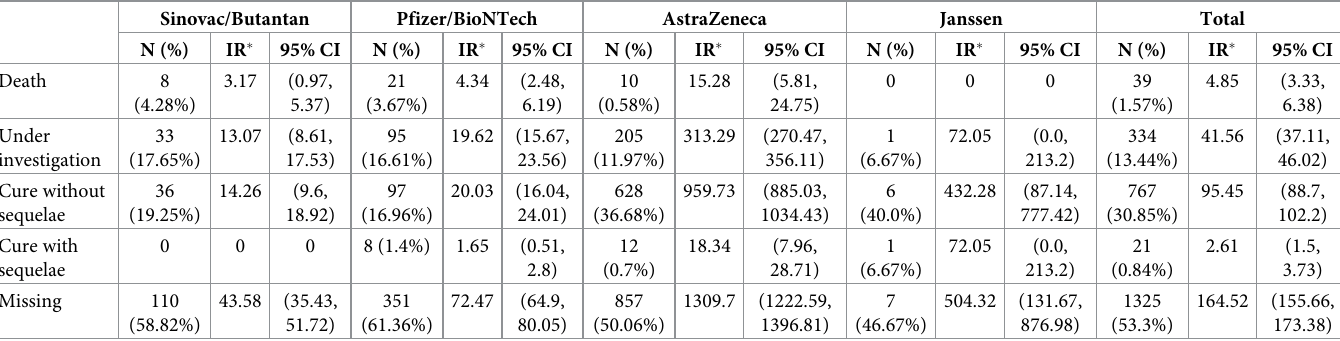
Table 4. Case evolution of the adverse events notifications according to the vaccine